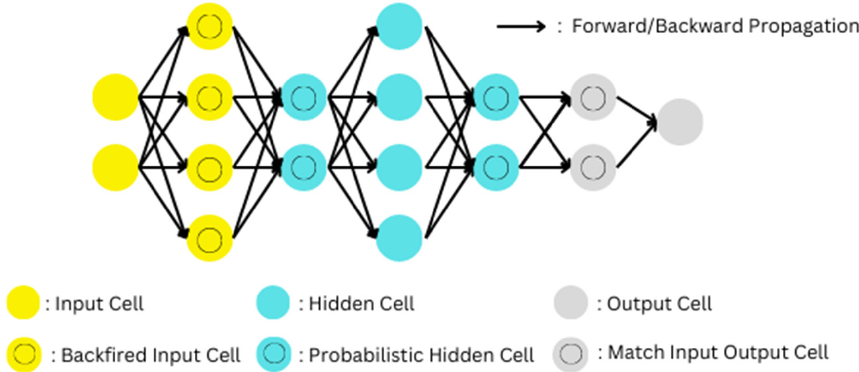
Figure 12. Theoretical representation of a Deep Belief Network.